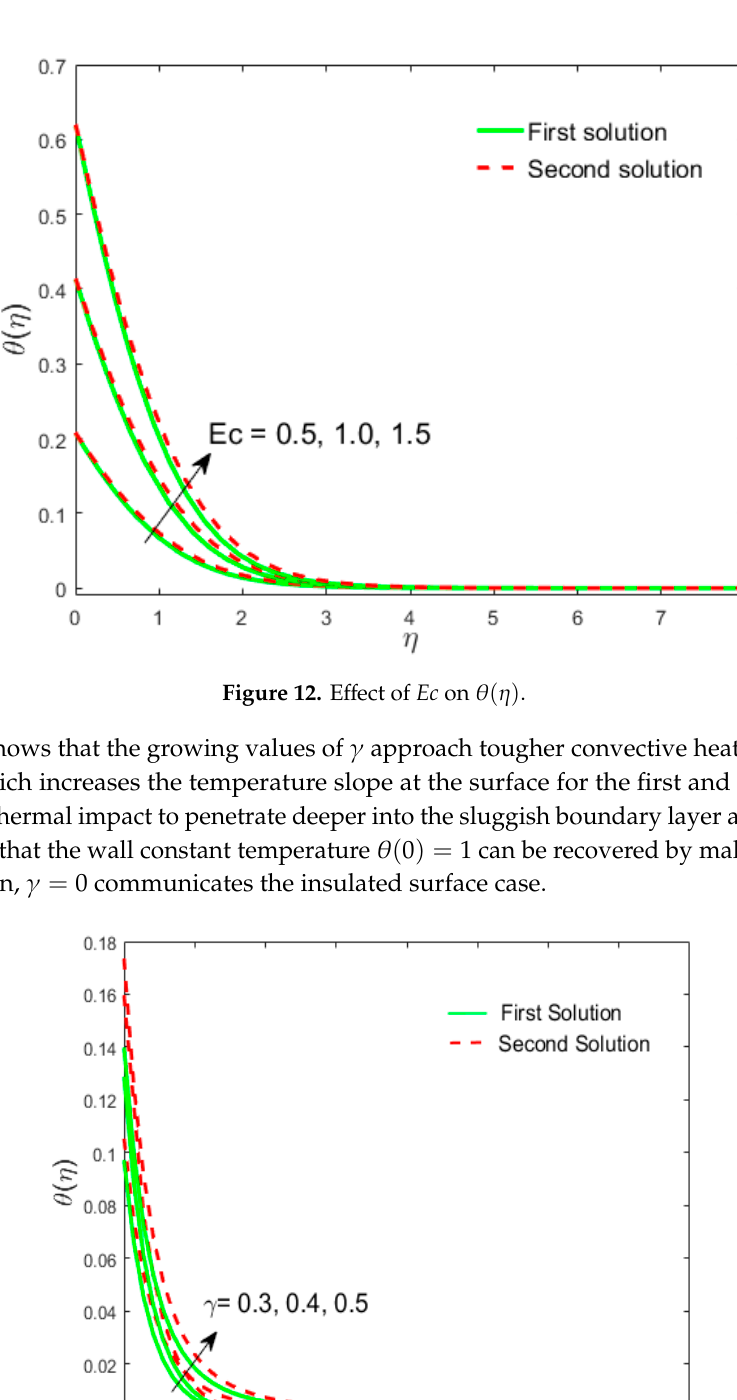
γ ( ) θη on . γ ( ) θη on . versus S are portrayed in Figures. 14 versus S are portrayed in Figures. 14